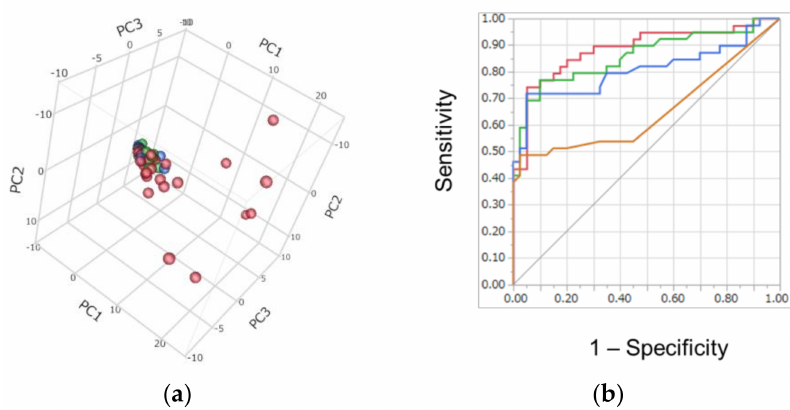
Figure 1. Discrimination ability of metabolomics profile: ( a ) Score plots of principal component analysis (PCA). Contribution ratio to first, second, and third principal component (PC) (PC1, PC2, and PC3) were 34.0, 5.7, and 4.7, respectively. Blue, green, and red plots indicated C, CP, and PC, respectively. ( b ) Receiver operating characteristic (ROC) curves of multiple logistic regression (MLR): red, green, blue, and orange curves indicated the MLR model with 4, 3, 2, and 1 metabolite(s), respectively, and their area under ROC curve (AUC) values were 0.887 (95% confidence interval (CI); 0.784–0.944,